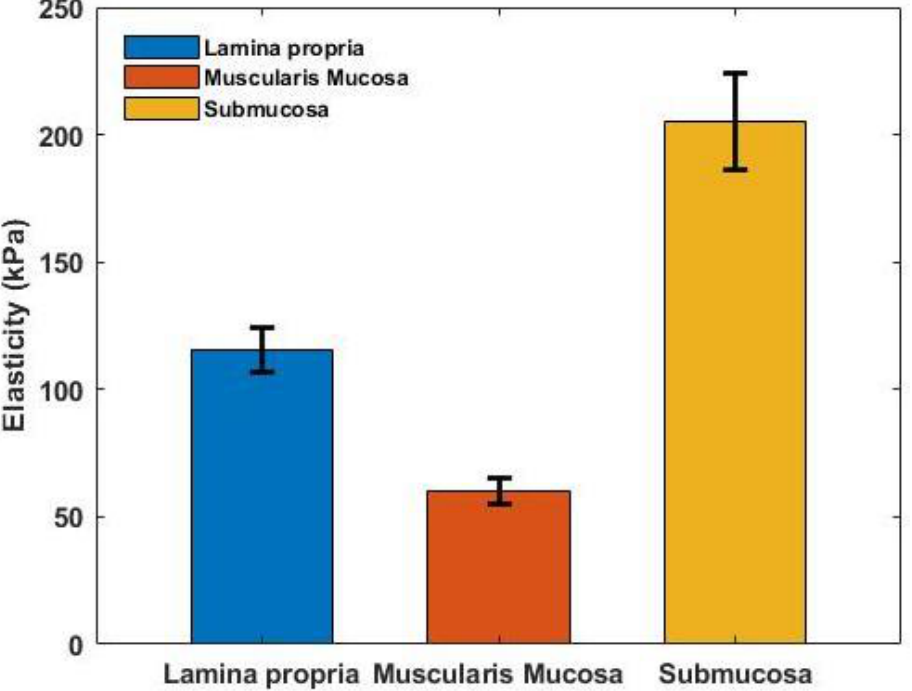
Figure 8. Averaged elastic modulus of lamina propria, muscularis mucosa and submucosa for 52 oesophageal tissue samples.